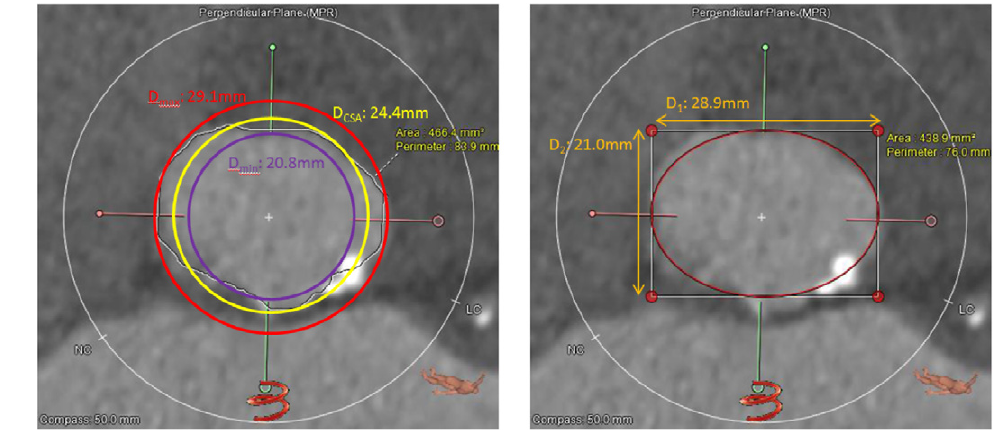
Figure. 4 Left: D min , D max , D CSA , Right: Elliptic description of the